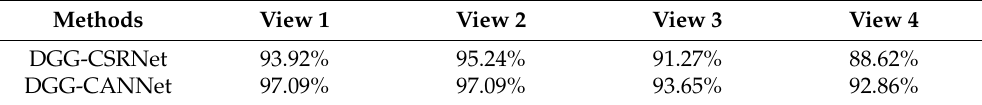
Table 4. The ‘ACC’ results of two different crowd counting methods.